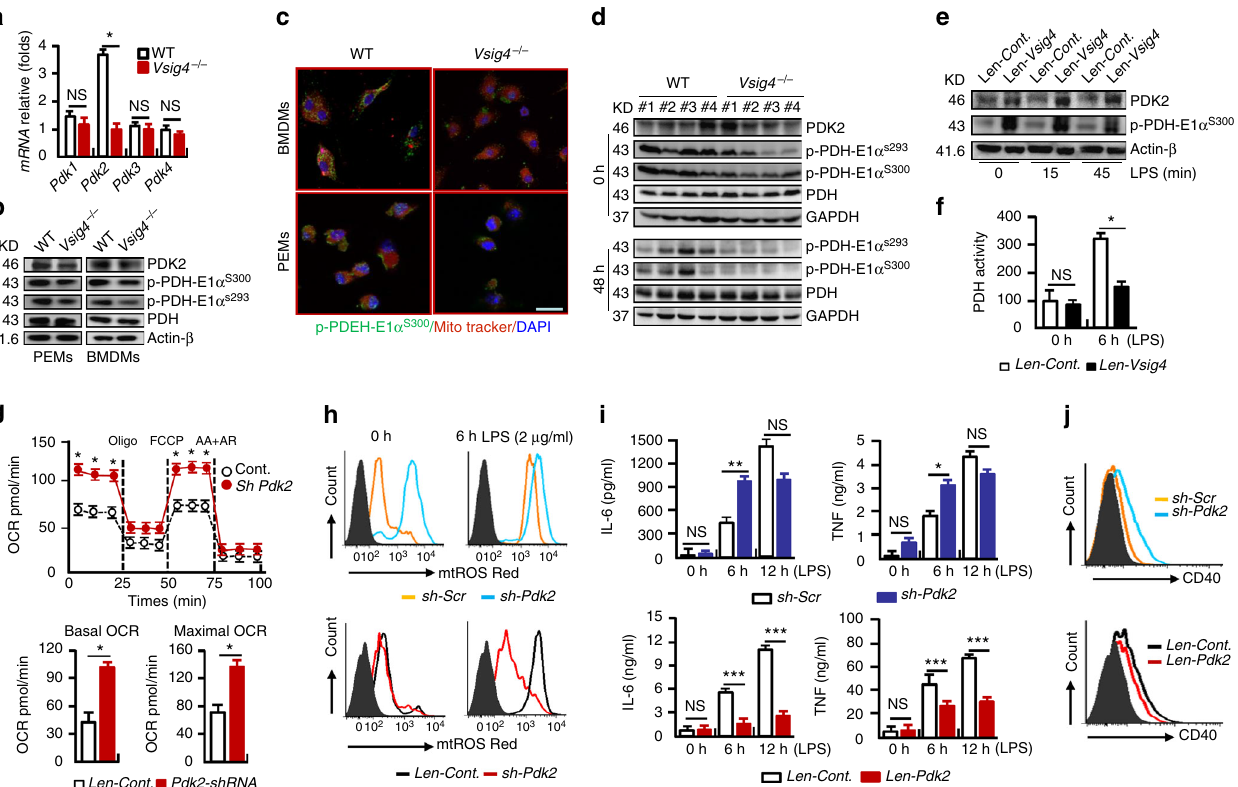
Fig. 5 VSIG4 triggers PDK2 expression in macrophages. Macrophages from WT and Vsig4 − / − mice were collected. a qRT-PCR detection of 4 Pdk isoforms in BMDMs. b Western blot analyzing PDK2, p-PDH-E1 α s300 , p-PDH-E1 α s293 , and total PDH. c The location of p-PDH-E1 α s300 in mitochondria was analyzed by immuno fl uoresence double staining, scale bar = 20 μ m. d Western blot of PDK2, p-PDH-E1 α s300 , p-PDH-E1 α s293 in liver tissues at 0 h and 48 h PI. RAW264.7 cells were transfected to expression of Vsig4 , and cells were further treated with LPS (2 μ g/ml), e Western blot analysis of PDK2 and p-PDH- E1 α s300 . f PDH activity analysis, n = 6 per group. The expression of Pdk2 in RAW264.7 cells was silenced by shRNA or enhancing Pdk2 expression by lentivirus infection. g Seahorse analysis of OCR after 2 h of LPS treatment (up), and basal and maximal OCR of the indicated conditions was plotted in bar graphs (down), n = 5 per group. h Flow cytometric assay of mtROS secretion after LPS administration. i ELISA of IL-6 and TNF in cultured supernatants, n = 4 per group. j Flow cytometric assay of LPS-caused CD40 expression at 6 h. Error bar, s.e.m. * p < 0.05,** p < 0.01, *** p < 0.001 and NS, p > 0.05 (Student ’ s t -test). Data are representative of three independent experiments NATURE COMMUNICATIONS | 8: